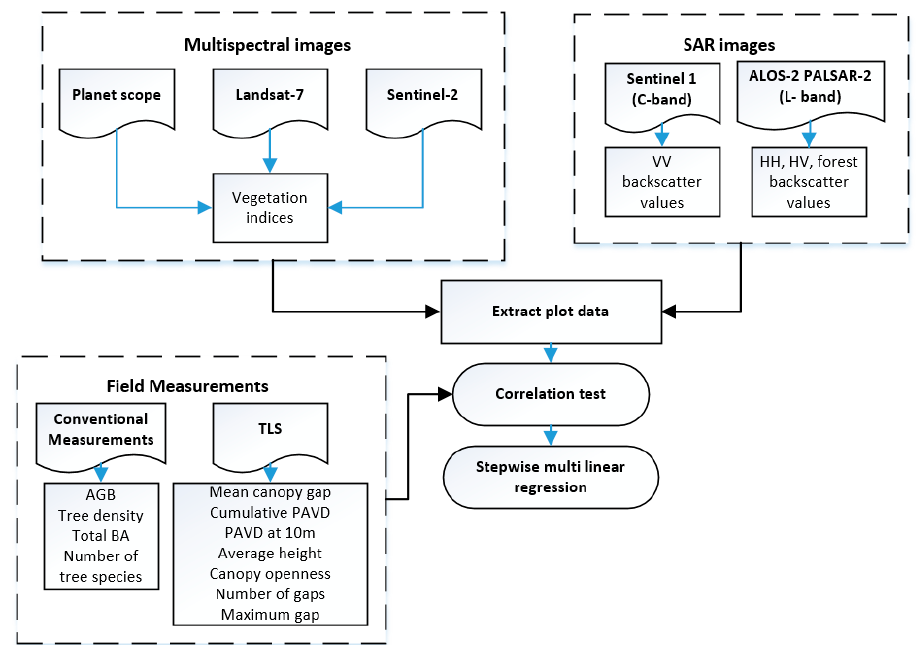
Figure 2. Data and methodological steps followed in estimating field-measured forest structure parameters using satellite remote sensing data. PAVD = plant area volume density, AGB = above ground biomass, BA = basal area.